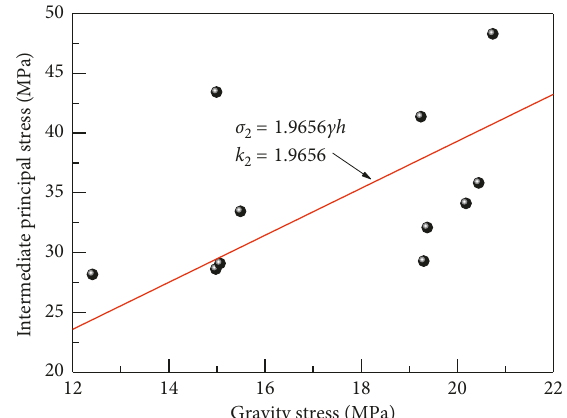
Figure 3: Relationship between intermediate horizontal principal stress and gravity stress.